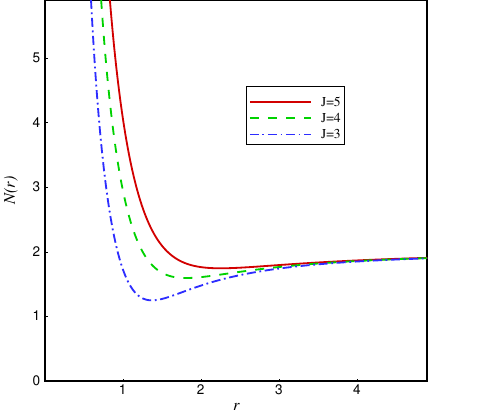
Figure 6 . The behavior of g ( r ) for rotating black hole in 3D with different b 0 , where we have taken l = 1 , J = 3 and M = 2 .